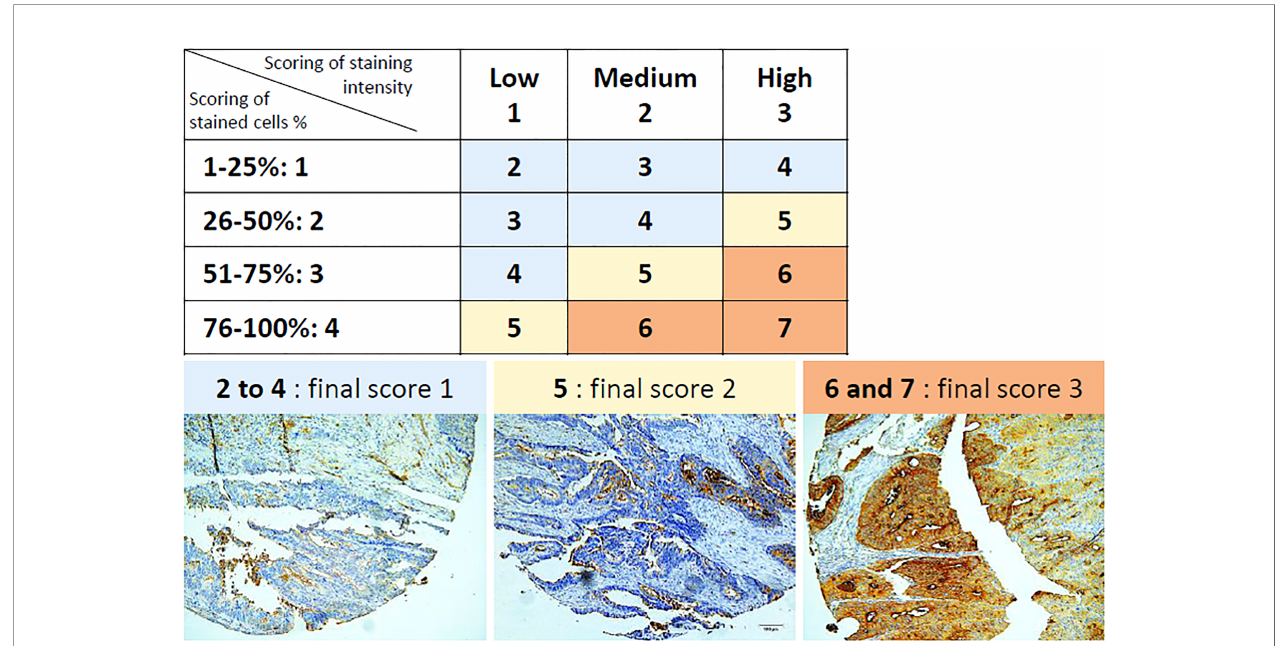
FIGURE 1 | Scoring method of IHC staining, according to percentages of stained cells and staining intensity. Percentages of stained cells are graduated into four scores (1 to 4) and staining intensity is graduated into three scores (1 to 3). The total some of both scoring results in intermediate scores ranging from 2 to 7. Intermediate scores ranging from 2 to 4 (in blue) result in a fi nal score of 1. Intermediate score of 5 (in yellow) results in a fi nal score of 2. Intermediate scores of 6 and 7 (in orange) result in a fi nal score of 3. Final scores of 1 and 2 are considered as “ Low staining ” and fi nal score of 3 is considered as “ High staining ” . Representative illustrations of MIX staining (in brown), as observed by IHC (magni fi cation, 200x), are depicted below table. IHC: Immunohistochemistry